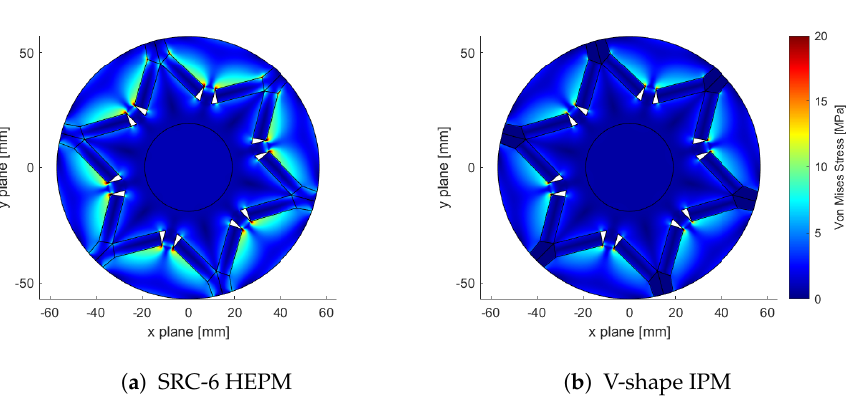
Figure 18. Mechanical stress of the SRC-6 HEPM and V-shape IPM